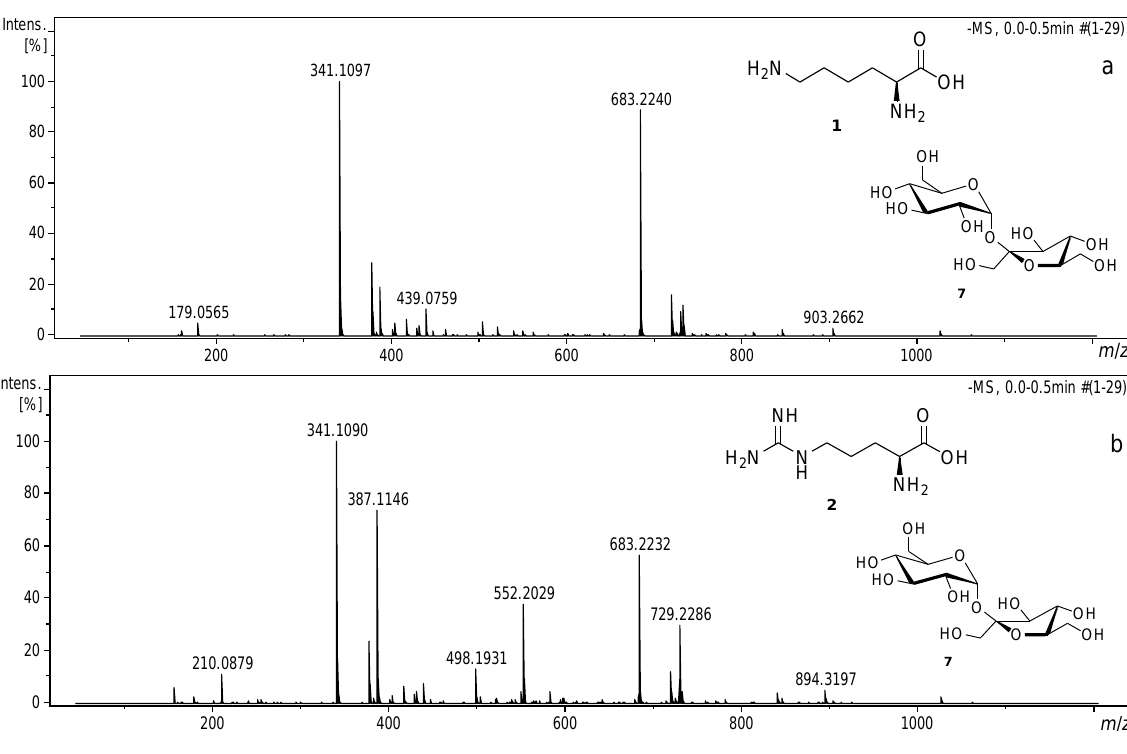
Figure 1. Mass spectra for heated: ( a ) lysine:sucrose (1:2), ( b ) arginine:sucrose (1:2), ( c ) aspartic acid:sucrose (1:2), ( d ) tyrosine:sucrose (1:2), ( e ) serine:sucrose (1:2) and ( f ) cysteine:sucrose (1:1) in negative ion mode using a direct infusion into an ESI-TOF-MS